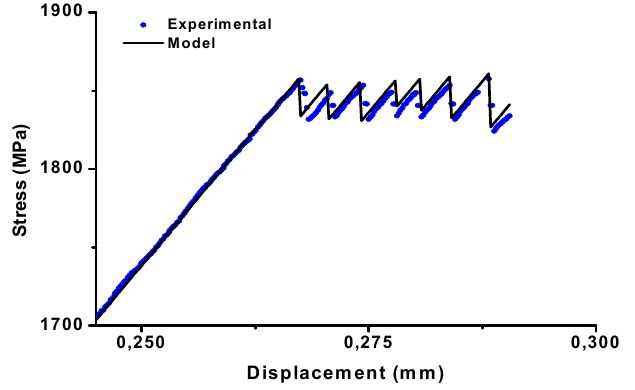
Figure 2. Stress-displacement curves of the deformed Zr-based glassy alloy. The line curve is the result obtained from the numerical simulation. Table 1. Fitting parameters used for the simulation of the serrated flow behavior in BMGs alloys. Results from literature were also presented for comparison.